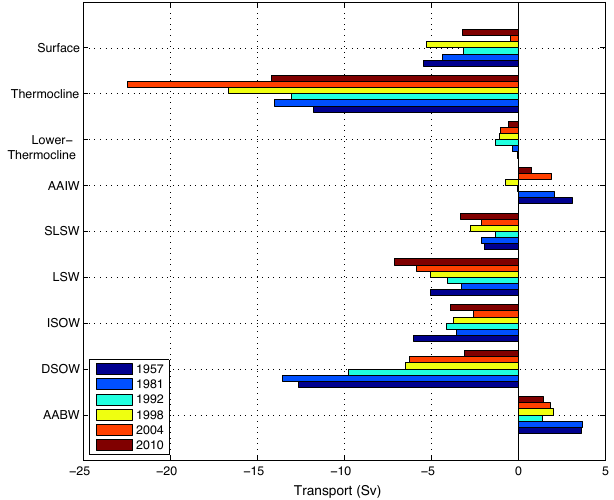
Fig. 11. Mid-Ocean transport for the six hydrographic sections in the potential temperature classes given in Table